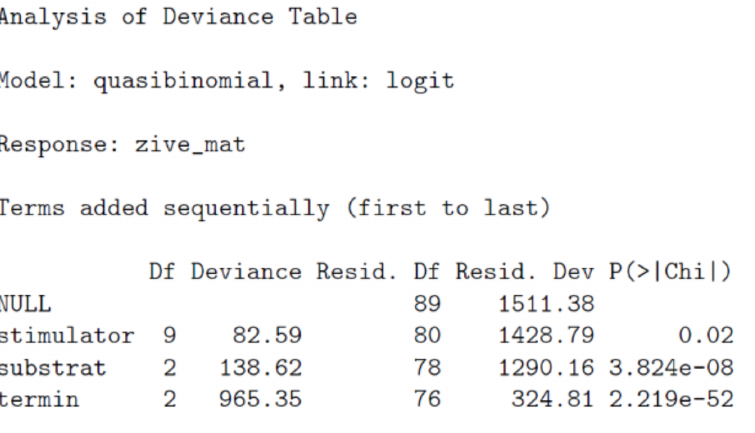
Figure A4. LR-test of the significance of factors for the proportion of survived cuttings from the total number of